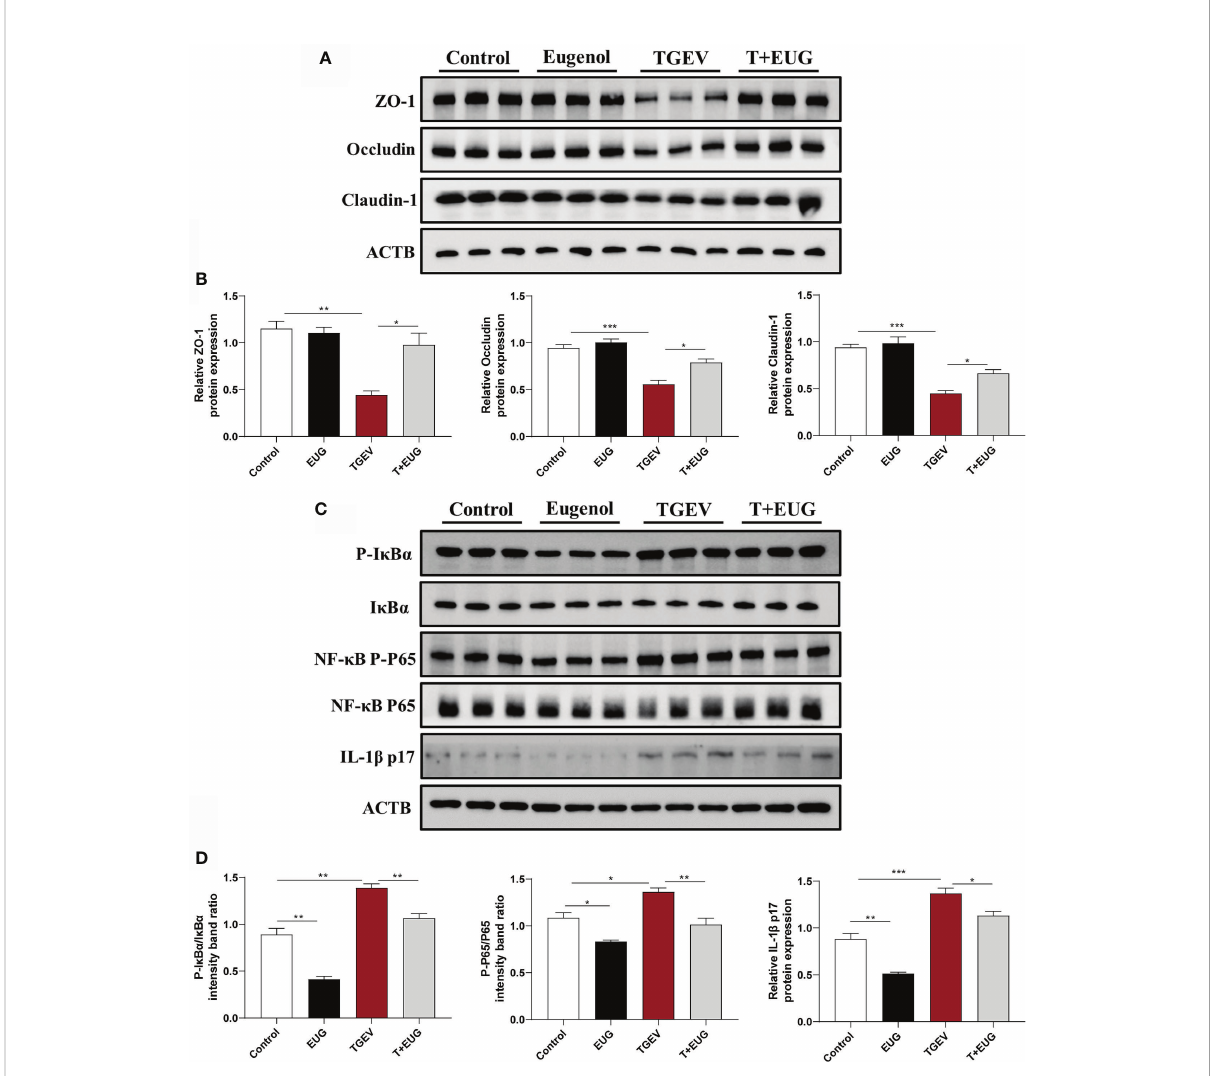
FIGURE 11 Eugenol alleviates TGEV-induced intestinal barrier damage in IPEC-J2 cells. IPEC-J2 cells were pretreated with eugenol (200 m M) for 1 h and then infected with TGEV for 36 h. (A, B) Immunoblot analysis and quanti fi cation of ZO-1 , Occludin and Claudin-1 in IPEC-J2 cells. (C, D) Immunoblot analysis and quanti fi cation of P-I k B a , I k B a , NF- k B P-P65 , NF- k B P65 and IL-1 b in IPEC-J2 cells. Data were expressed as mean ± SEM. * p < 0.05, ** p < 0.01, *** p <